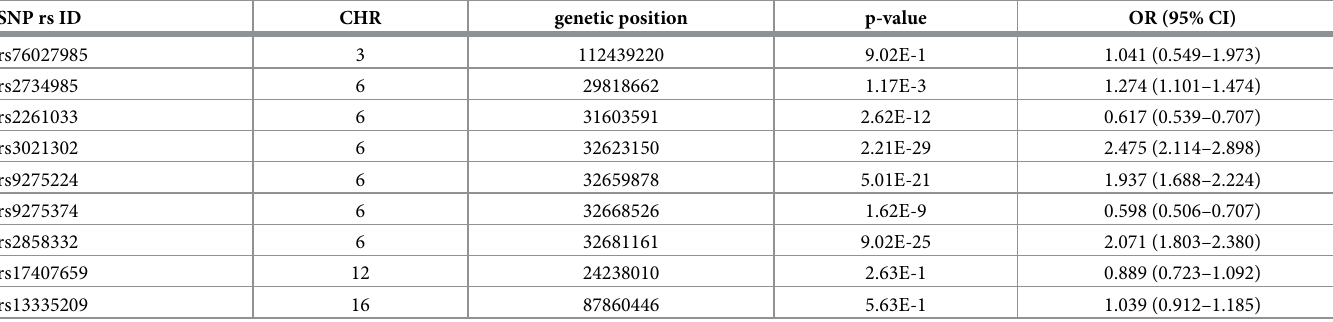
Table 5. Association of meQTLs with SS in European